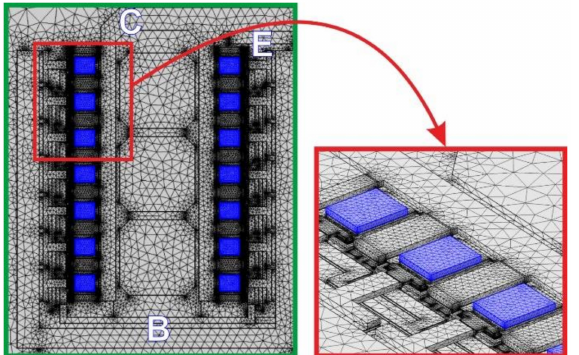
Figure 7. ( Left ) Half of the 28-cell array (with seven cells per column) built in the COMSOL envi- ronment ( mesh mode ). The numbers of tetrahedra and DoFs are 3.7 × 10 6 and 4.9 × 10 6 , respectively. ( Right ) Magnification of some unit